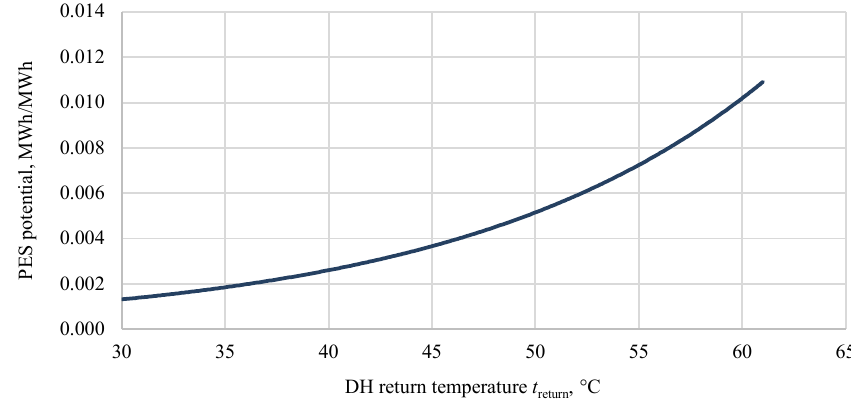
Fig. 6. PES increase potential per 1 MWh with DH return temperature reduction by 1 °C at different DH return